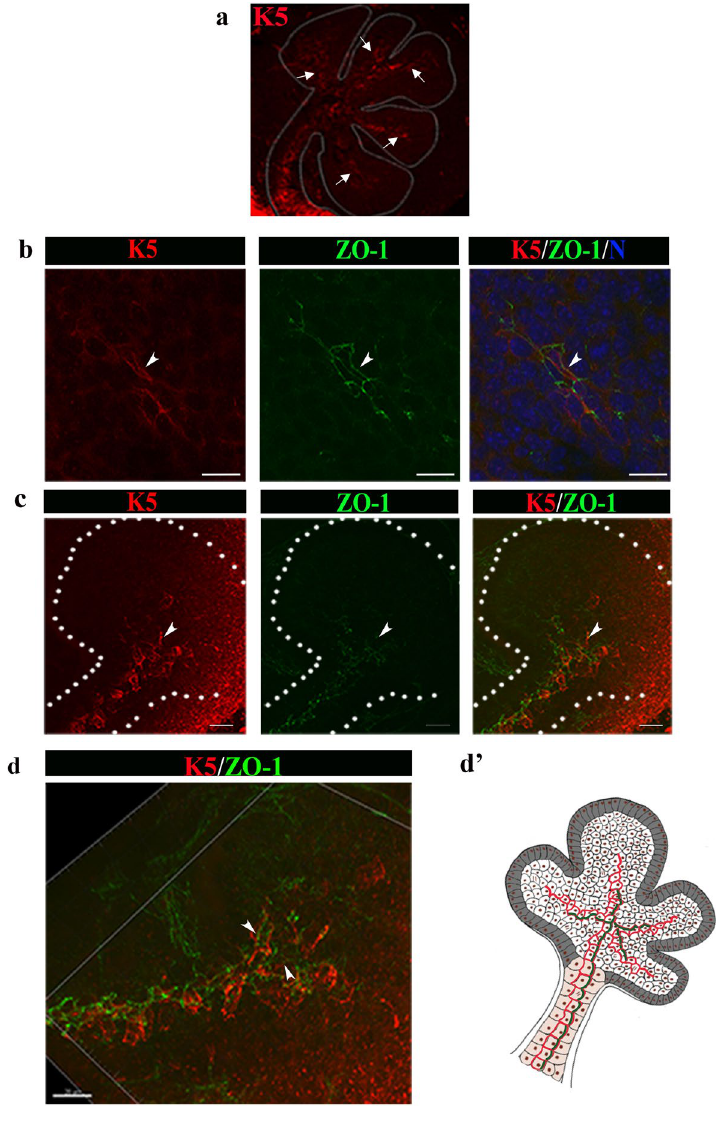
Figure 2. F-actin and ZO-1 establish asymmetry in K5 progenitor cells. ( a ) In addition to marking the ductal path in proximal bud region, extending ducts in E13.5 SMGs comprised K5 + cells at distal sites ( → ). ( b ) K5 + cells (red, → ) in the proximal bud exhibit ZO-1 asymmetries (green, → ); nuclei are marked by the blue TOPRO-3 stain. ( c ) K5+ cells in the proximal region of the sublingual gland displayed ZO-1 at sites of asymmetry ( → ). ( d ) 3D volumetric rendering with Imaris software of the sublingual gland in ( c ) revealed the organization of K5 + ductal progenitors relative to their ZO-1 asymmetries in the proximal region of the forming ductal tree ( → ) . Size bars, 20 µm. ( d’ ) Schematic representation of K5 + cells with ZO-1 asymmetries in the developing ductal regions of the salivary gland in ( a – d , red, green). Results show representative images of 5 experiments (n =